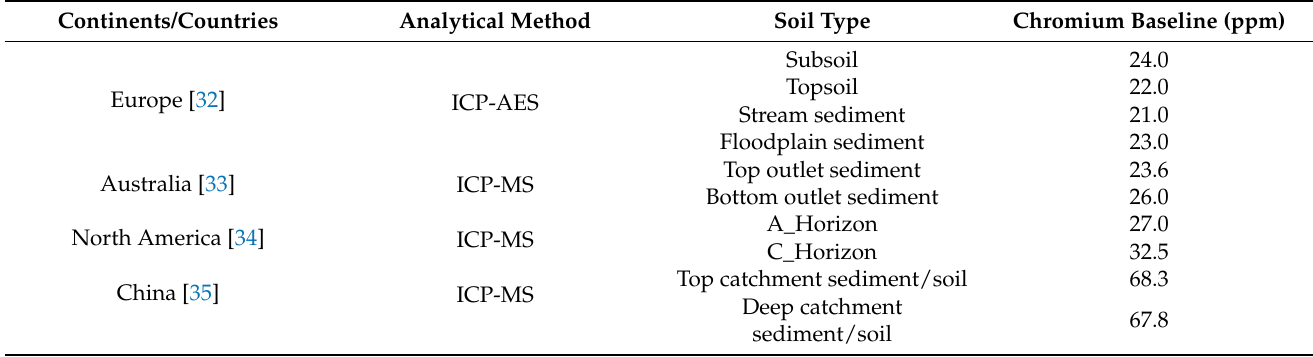
Table 3. Comparison of chromium baselines between PNG and other continents/countries.